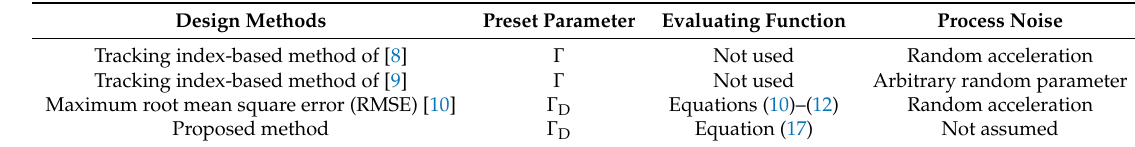
Table 1. Summary of the conventional and proposed design